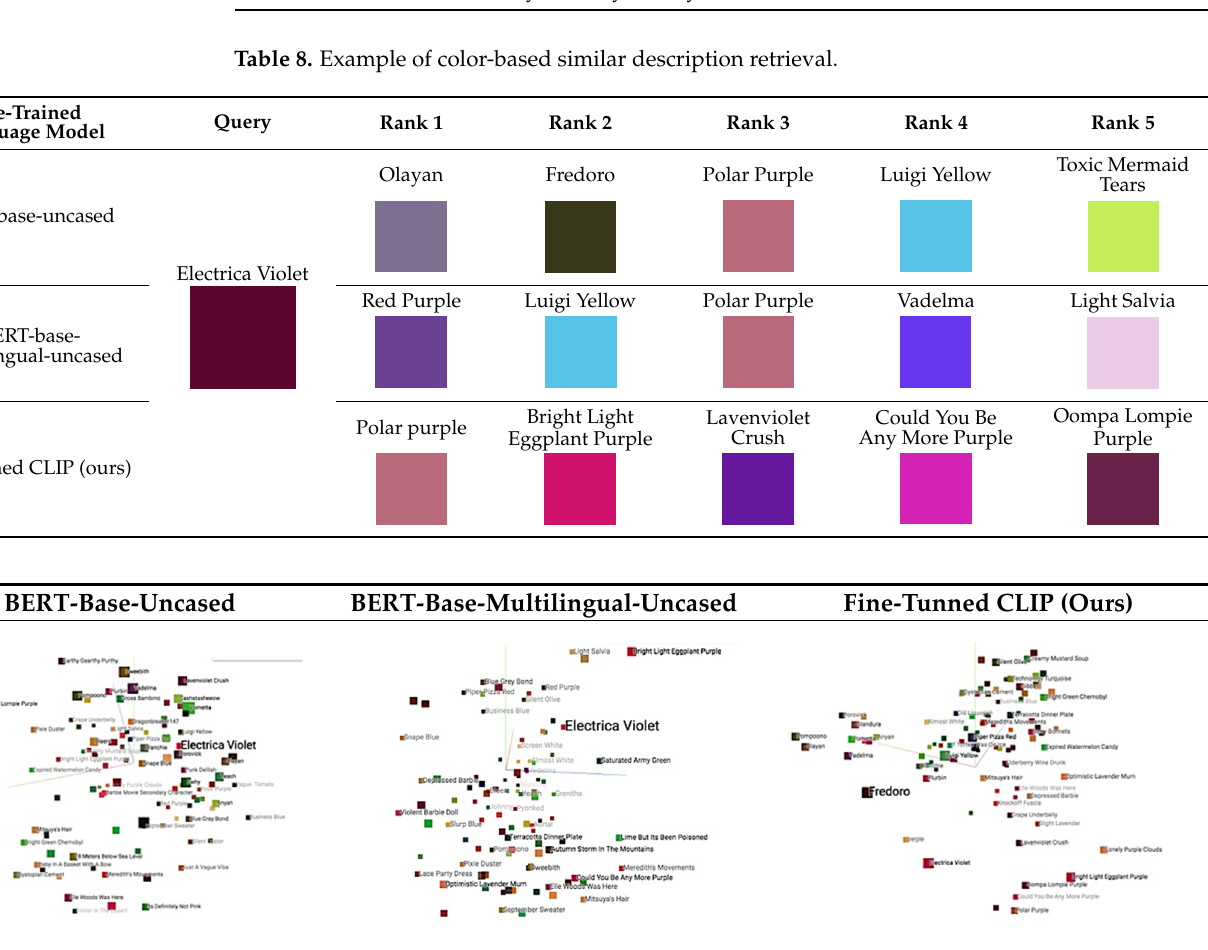
Table 7. Examples of color names collected from colornames.org.